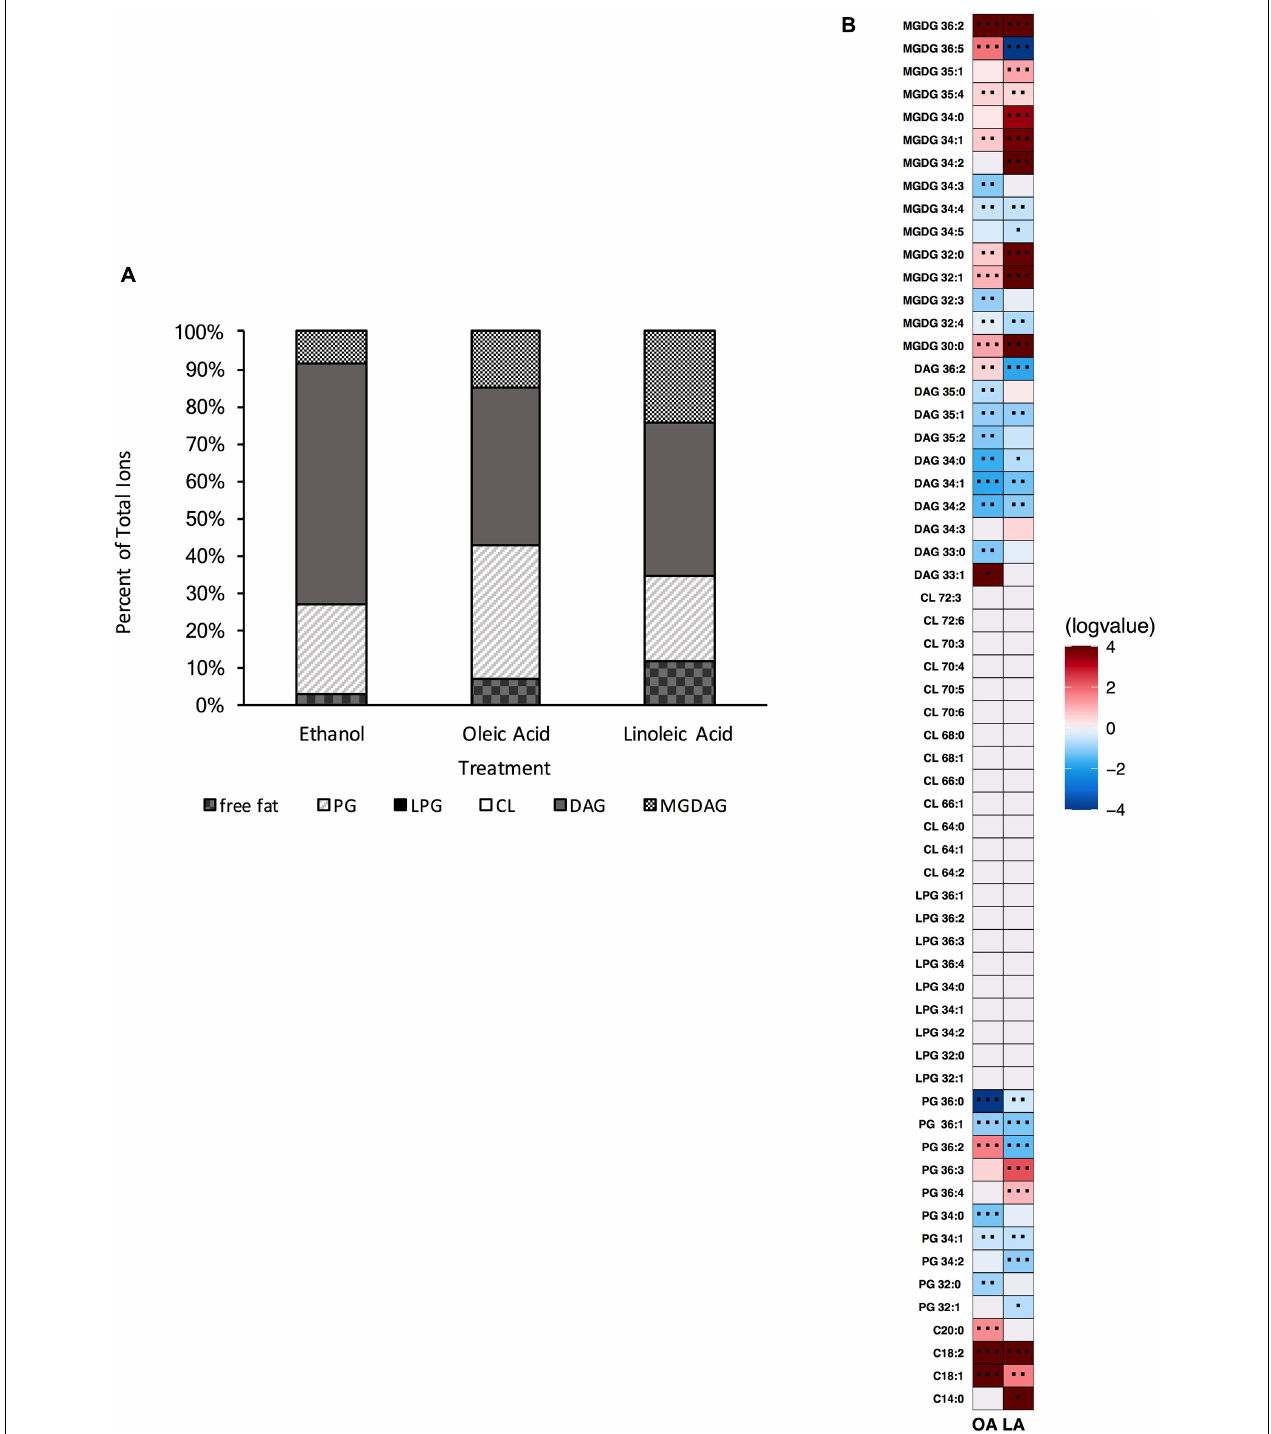
FIGURE 8 | A strain deleted for (cid:49) mprF2/cls1/cls2 can alter its lipid composition upon exposure to host fatty acids. (A) Percent totals of lipid species in solvent control: free fatty acids (2.6%), PG (24.5%), L-PG (0.0%), CL (0.0%), DAG (64.7%), and MGDG (8.3%), oleic acid: free fatty acids (7.0%), PG (35.8%), L-PG (0.0%), CL 0.0%), DAG (64.7%), MGDG (14.8%), linoleic acid: free fatty acids (11.7%), PG (23.0%), L-PG (0.0%), CL (0.0%), DAG (40.8%) MGDG (24.5%). Species were normalized to OD 600 nm . (B) Heat-map of fold changes upon fatty acid supplementation vs. solvent control; OA, oleic acid supplementation; LA, linoleic acid supplementation. Shown are the average fold changes of those detected lipid species above limit of detection for n = 5 samples. * P = 0.1–0.05; ** P = 0.05–0.01; *** P <